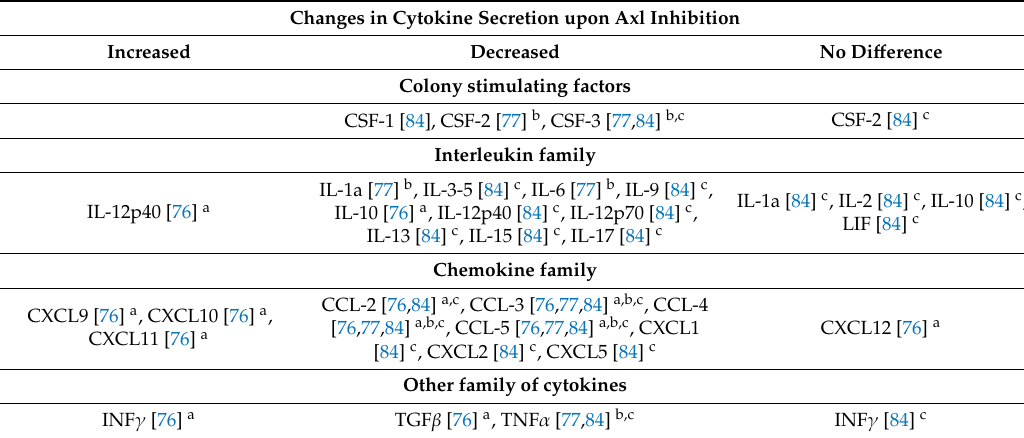
Table 1. Axl Signaling Modulates Secretion of